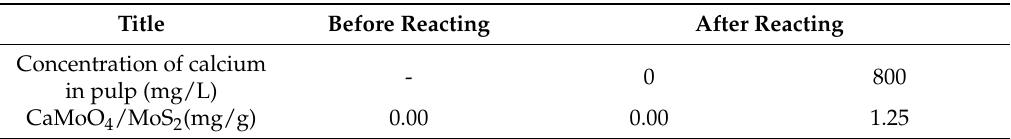
Table 3. The amount of CaMoO 4 formed in the PM sample before and after conditioning in the absence and presence of 800 mg/L Ca 2+ at pH 8. Before Reacting After Reacting Concentration of